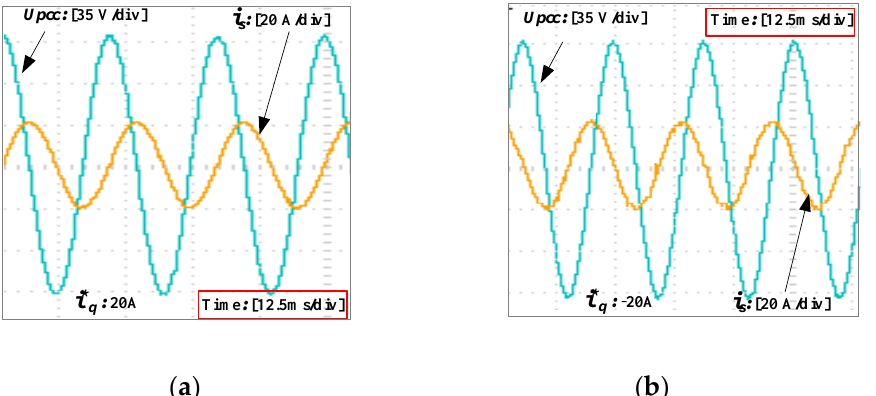
Figure 13. Waveforms of U PCC and i s without PLL. ( a ) Inductive reactive current; ( b ) capacitive reactive current.